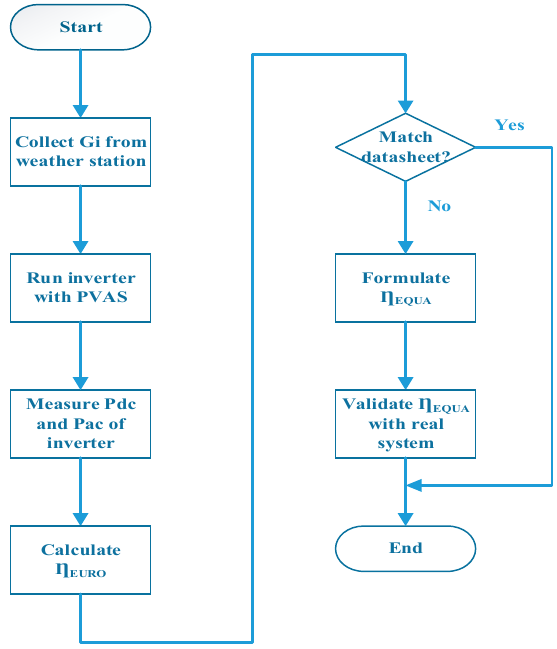
Figure 4. Flowchart of the methodology.